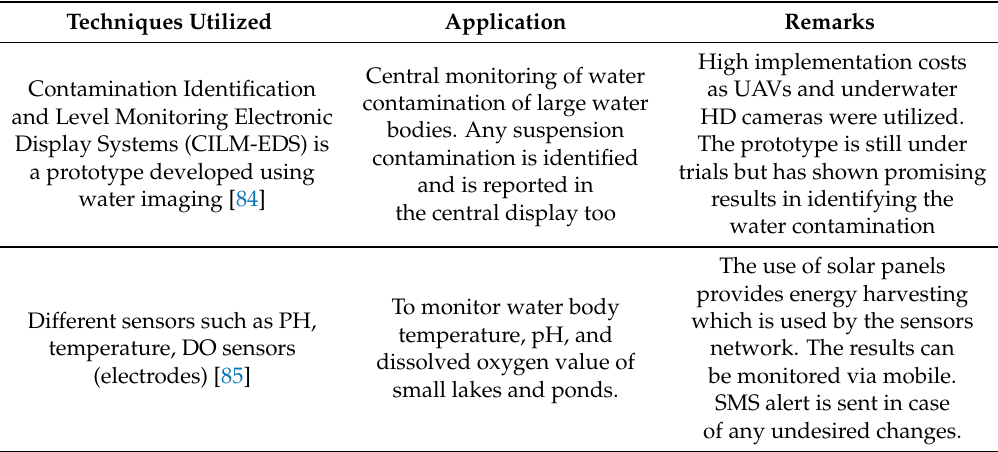
Table 4. Various prototypes for water body